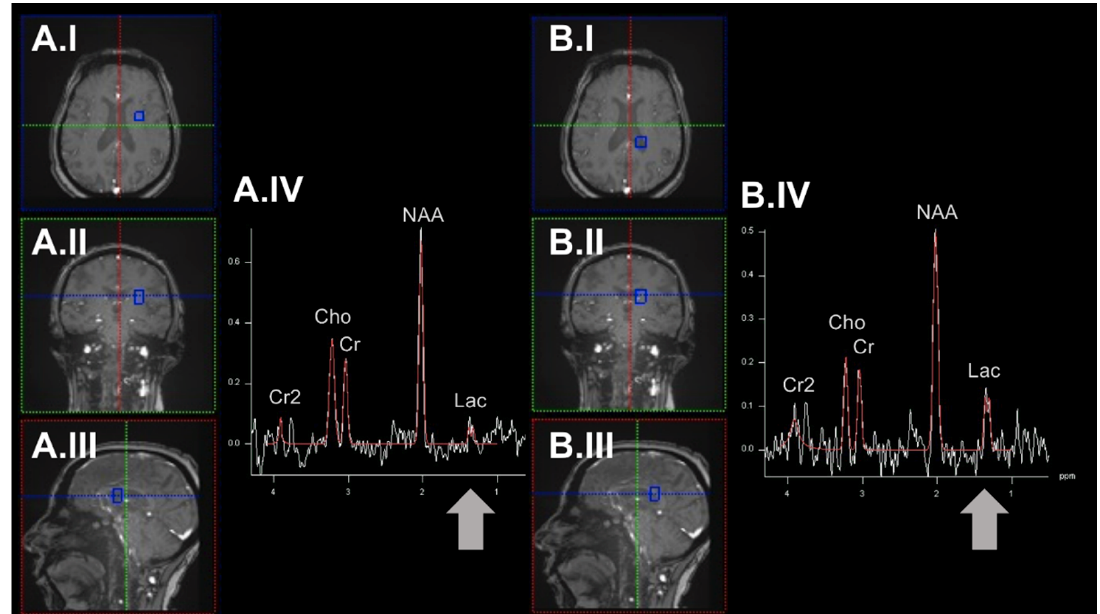
Figure 2. Exemplary determination of region-specific lactate levels by employing the 1 H-MRSI methodology. Here, we demonstrate spectra derived from an example voxel (highlighted in blue) in the brain parenchyma of the left hemisphere (panel A) and the posterior portion of the left lateral ventricle (panel B). The respective voxel placement is shown in axial (A.I/B.I), coronal (A.II/B.II), and sagittal orientation (A.III/B.III). In this example, higher lactate levels can be observed in the CSF of the lateral ventricle. 1 H-MRSI: proton magnetic resonance spectroscopy imaging. Cho: choline. Cr/Cr2: creatinine. CSF: cerebrospinal fluid. Lac: lactate. NAA: N-acetyl aspartate. ppm: parts per million.